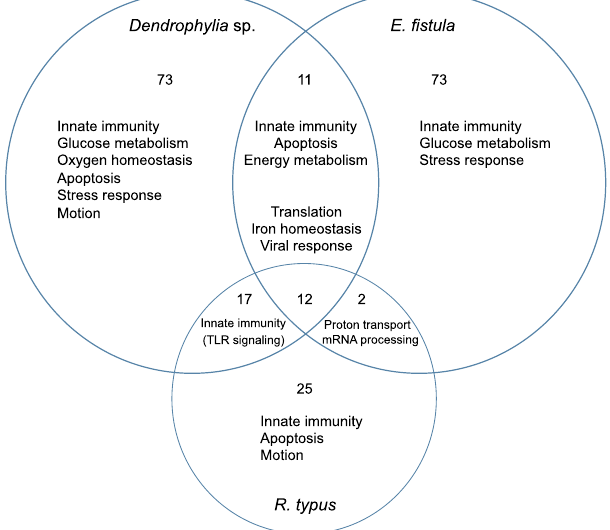
Figure 2. Overview of selected enriched GO biological process terms for highly expressed genes (FPKM > 100). Values represent the number of shared and exclusive GO terms of three deep-sea coral species from the Red